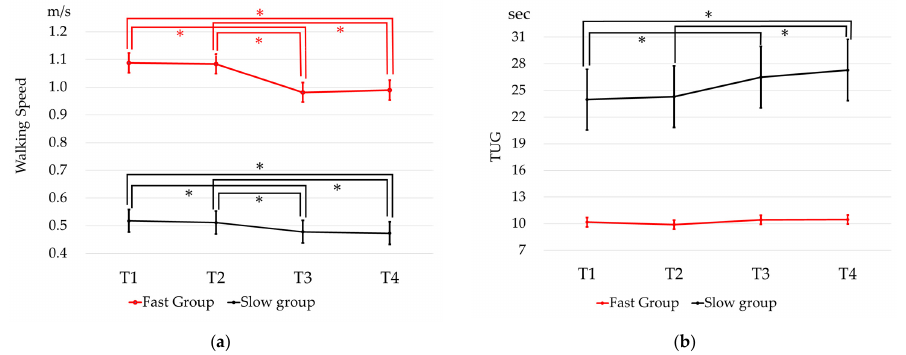
Figure 3. The physical data of each group (Fast group and Slow group) at each time period. Slow group, T1–T2 mean walking speed < 1.0 m/s; Fast group, T1–T2 mean walking speed ≥ 1.0 m/s. ( a )